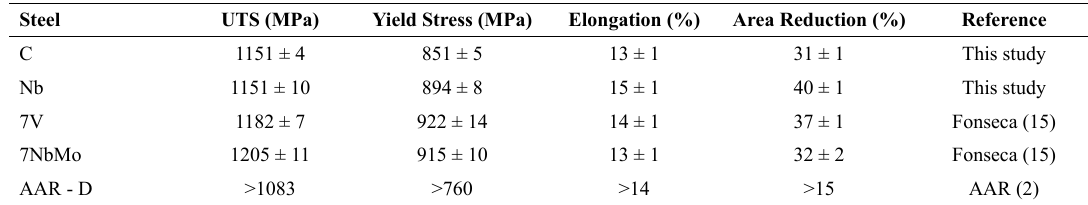
Figure 8. Location of micrographs on the Nb steel wheel rim. Table 3. Results of tensile test and toughness at 25 ºC.